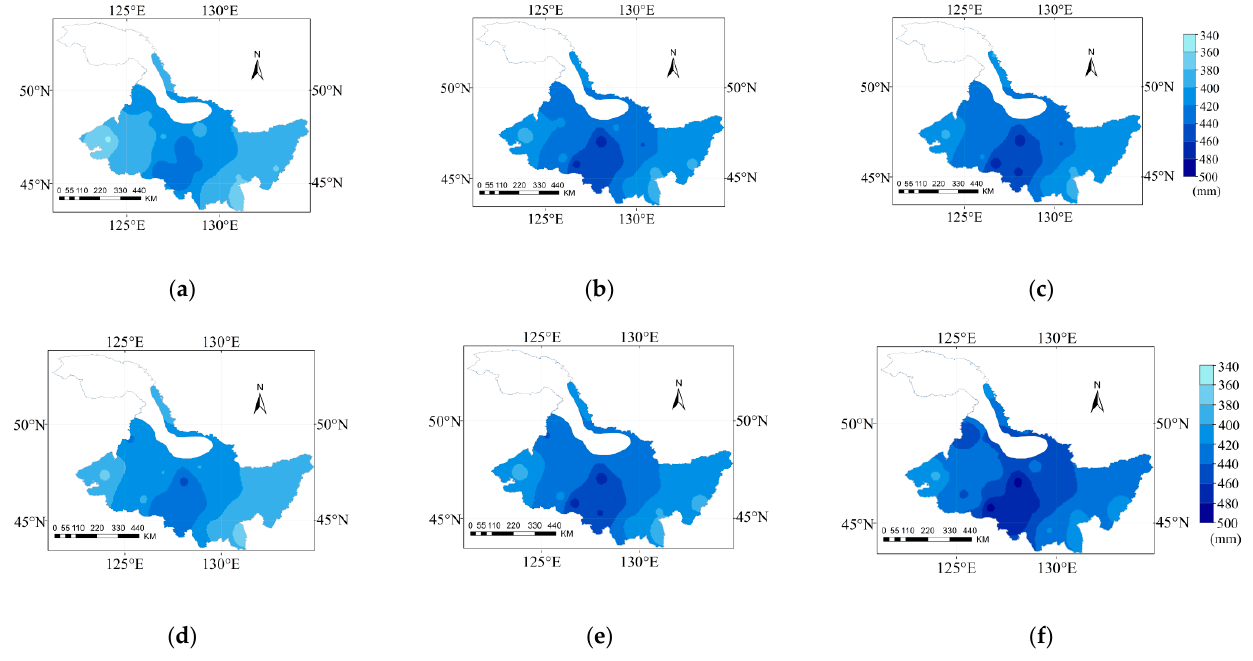
Figure 6. Spatial distribution of crop water requirement ( ET c ) during the ( a ) 2030s, ( b ) 2050s, and ( c ) 2070s under RCP4.5, and during the ( d ) 2030s, ( e ) 2050s, and ( f ) 2070s under RCP8.5 during the soybean growth period.